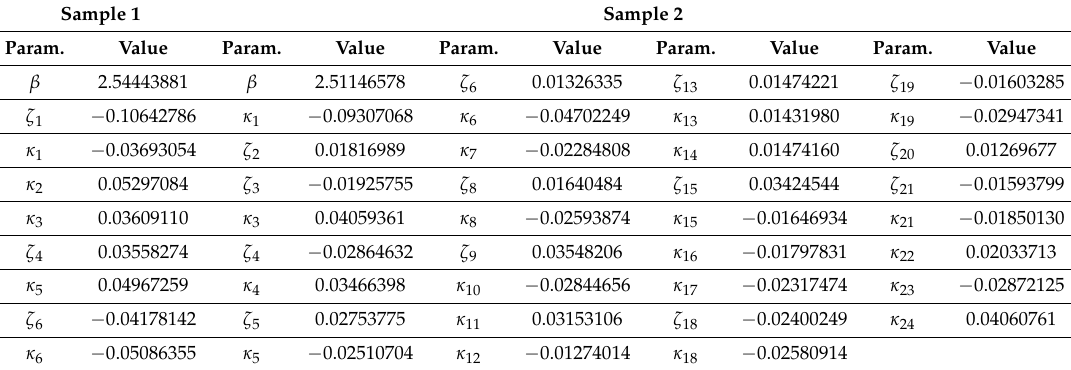
Table A4. Estimated parameter (Param.) of T